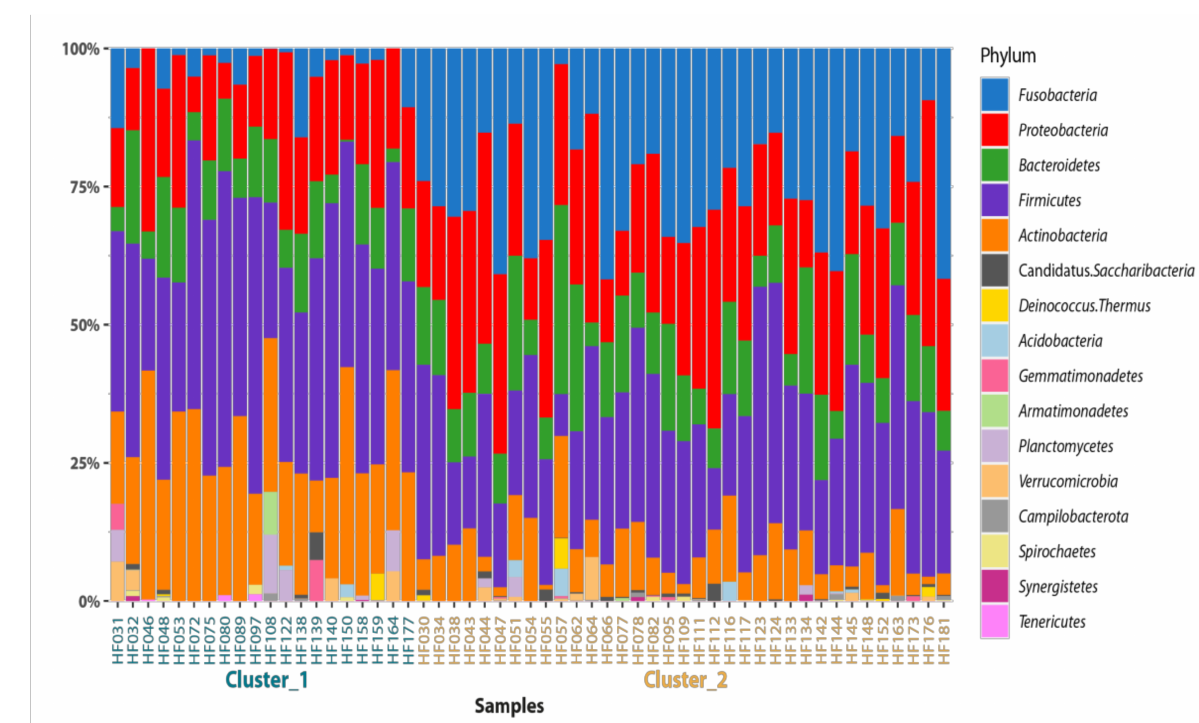
Figure 3. Relative abundance of bacterial phyla present in ejaculates of clinically healthy breeding bulls. Table 1. Core microbiome dominant groups (above 2% in any cluster) in Holstein Friesian semen samples. The table depicts the average microbiome share for each taxa in identified clusters accompanied with standard errors and differences in their distribution in clusters according to Wilcoxon